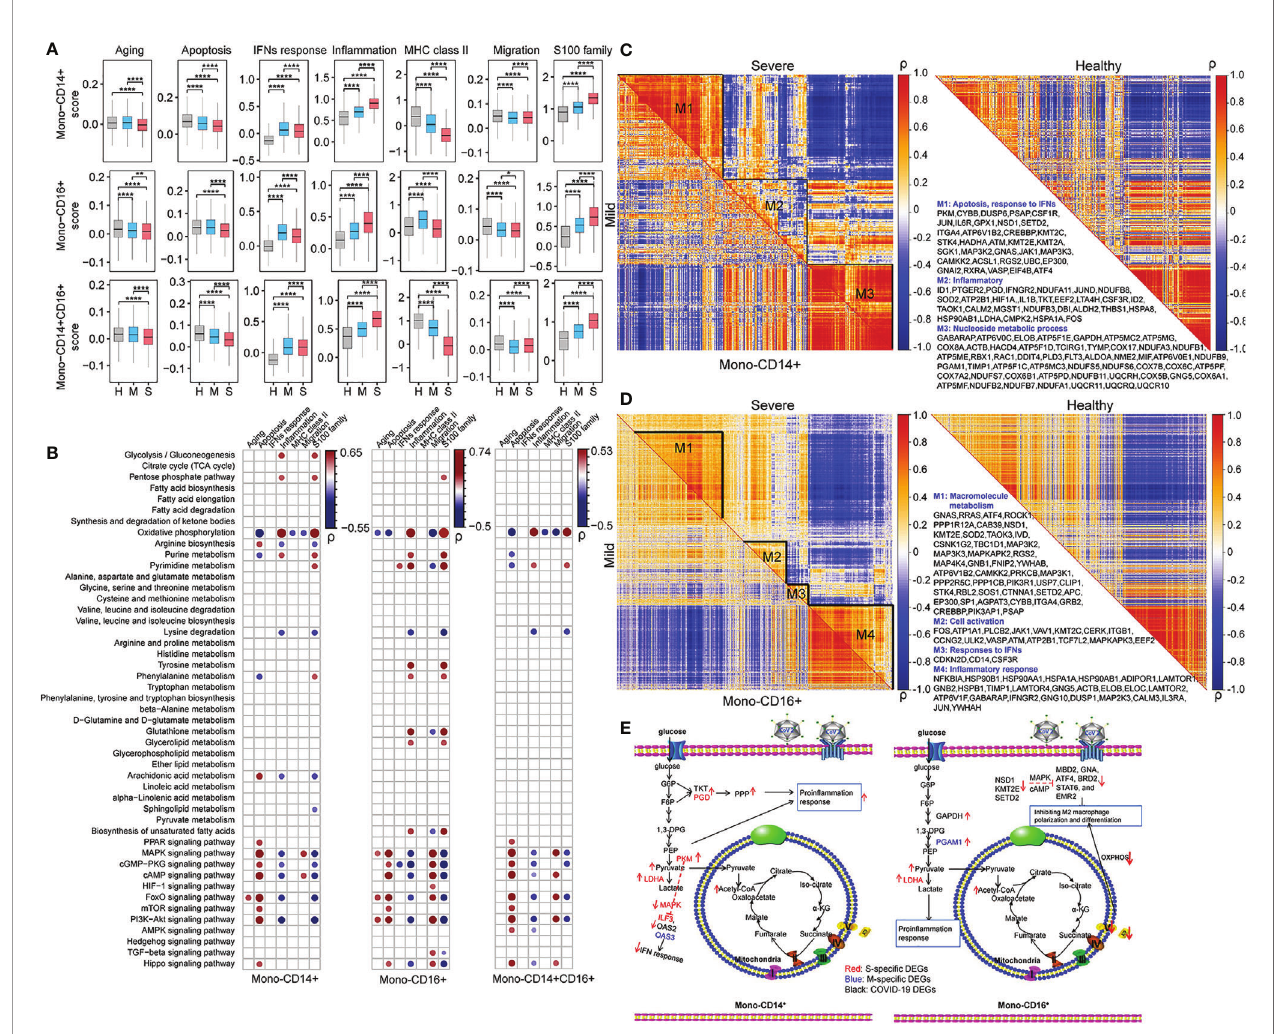
FIGURE 3 | Dysfunction of monocytes was connected with metabolic reprogramming in COVID-19 patients. (A) The selected functional changes in mono-CD14 + , mono-CD16 + , and mono-CD14 + CD16 + cells in patients with mild or severe disease (Student ’ s t-test; * P < 0.05; ** P < 0.01; **** P < 0.0001). H, healthy controls; M, patients with mild COVID-19, and S, patients with severe COVID-19. (B) The Pearson correlations between the scores of monocyte function and metabolic processes and signaling pathways in mono-CD14 + (left panel), mono-CD16 + (middle panel) and mono-CD14 + CD16 + (right panel) cells. “ r ” indicates the Pearson correlation coef fi cient; only dots representing correlations with | r | > 0.2 and P < 0.05 are shown. (C, D) The coexpression modules of DEGs in mono-CD14 + and mono-CD14 + CD16 + cells. The metabolism-related genes are displayed. The coexpression modules in patients with mild and severe disease are shown in the lower triangle and upper triangle, respectively. The coexpression modules in healthy controls are shown in the right panel. “ r ” indicates the Pearson correlation coef fi cient. (E) The delineation of metabolism-immune response crosstalk in mono-CD14 + and mono-CD16 + cells in COVID-19 patients according to the DEGs and the KEGG pathways in which they participate. The S-speci fi c DEGs are shown in red. The M-speci fi c DEGs are shown in blue. The DEGs in COVID-19 patients are shown in